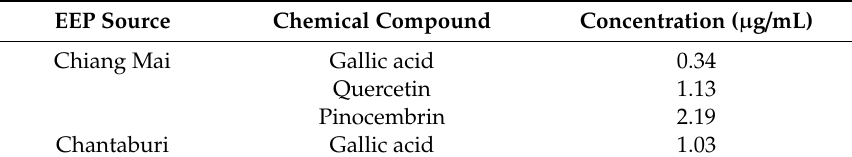
Table 2. Results of high-performance liquid chromatography EEP.